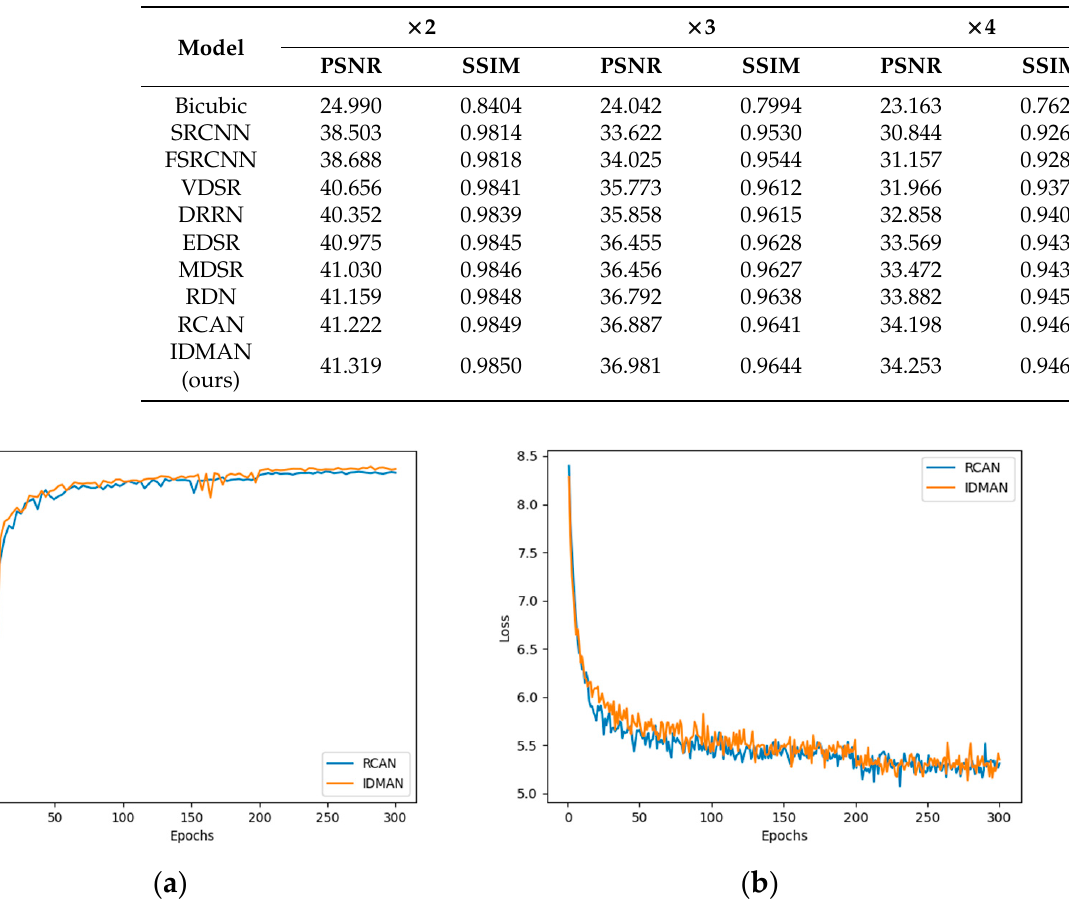
Figure 7. Convergence analysis with scaling factor × 2: ( a ) The PSNR curve during training; ( b ) The L1 loss curve during training.